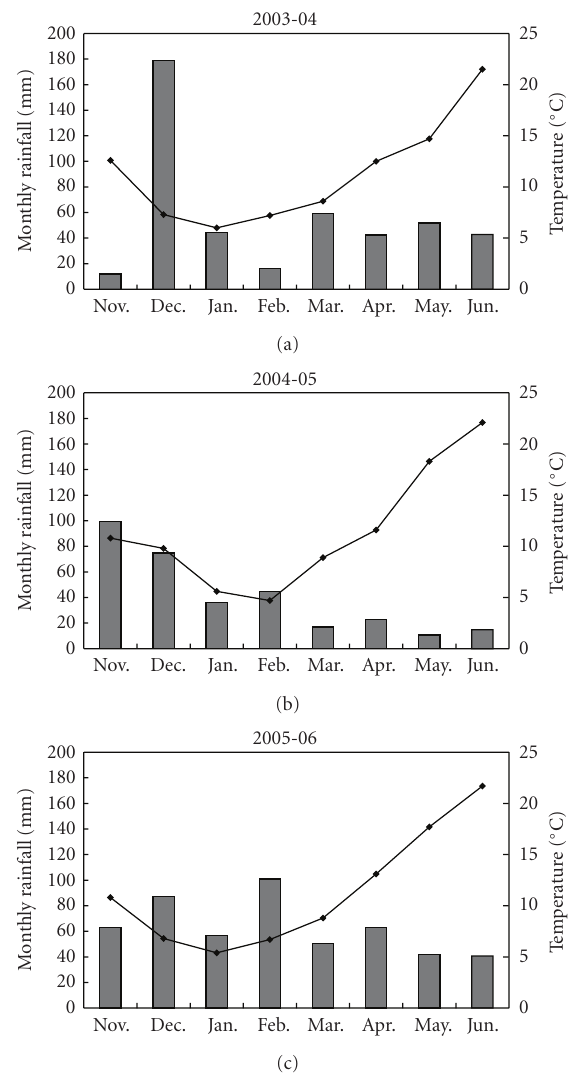
Figure 1: A graphic representation of the behavior of the lines according the first three principal components and identification of clusters. The behavior in each year is represented by a letter (line code) and a number (1 = 2004; 2 = 2005; 3 =